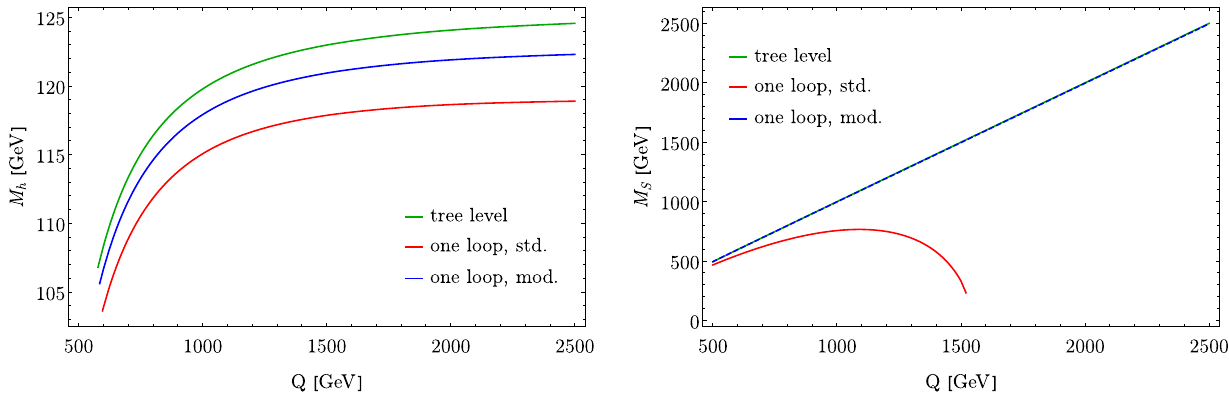
Fig. 3 M h (left) and M S (right) as a function of m tree for the different curves are the same as in Fig. 2